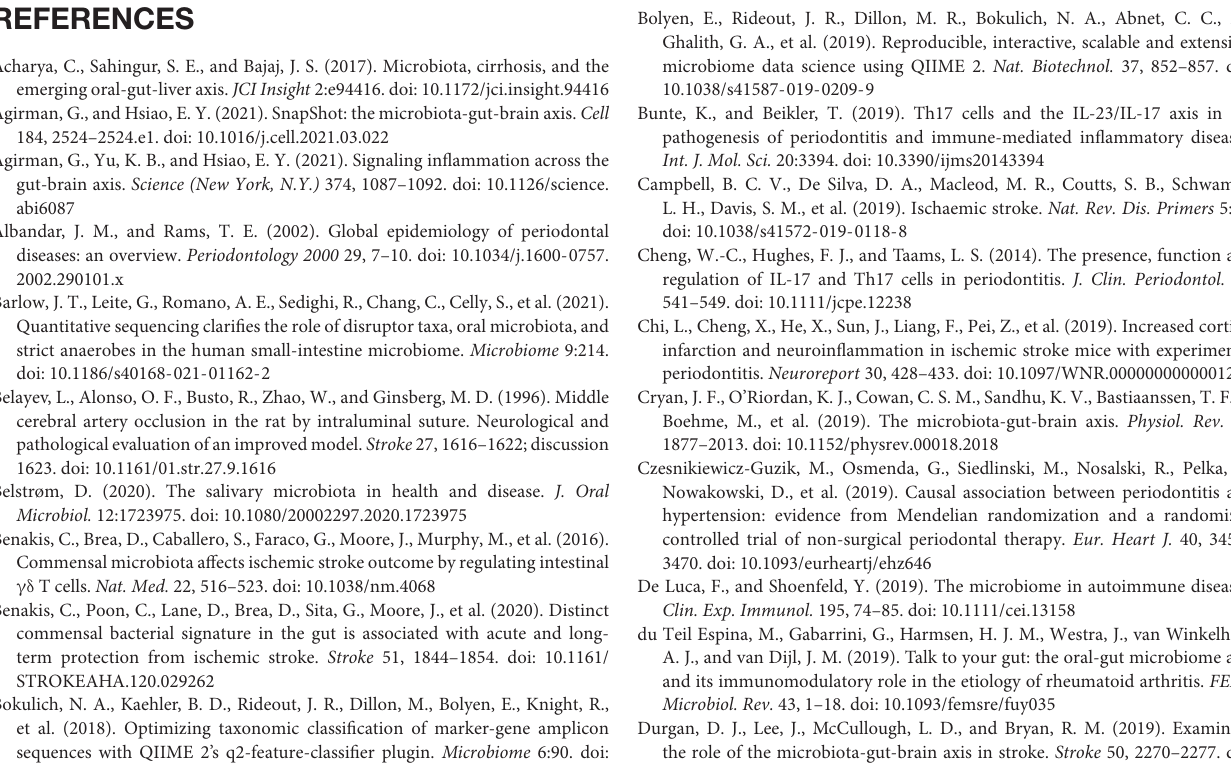
periodontal bacteria in mouse feces by qPCR. Values represent mean ± SD . ns, not significant. ∗ p < 0.05, ∗∗∗∗ p < 0.0001. Supplementary Figure 2 | (A) Gating strategy for flow cytometry analysis of the brain immune cells. (B) Gating strategy for flow cytometry analysis of the intestinal immune cells. Supplementary Figure 3 | Flow cytometry analysis of brain immune cells. (A) Gavage of salivary microbiota of periodontitis patients does not significantly alter the number of CD45 int CD11b + cells in the ischemic brain 1 day after ischemic stroke. Left, representative flow cytometry analysis of CD45 int CD11b + cells. Right, quantification of CD45 int CD11b + cells. n = 6:5:6:6. (B) Gavage of salivary microbiota of periodontitis patients does not significantly alter the number of CD45 int CD11b + CD86 + cells in the ischemic brain 1 day after ischemic stroke. Left, representative flow cytometry analysis of CD45 int CD11b + CD86 + cells. Right, Supplementary Figure 4 | Flow cytometry analysis of CD4 + T cells and TCR- γδ + T cells. The ASPP group had comparable CD4 + T cells and TCR- γδ + T cells with the ASDW and MCAO groups in the small intestine and colon. (A) Quantification of CD45 + CD4 + cells in the small intestine. n = 5:5:6:6. (B) Quantification of CD45 + TCR- γδ + cells in the small intestine. n = 5:5:6:6. (C) Quantification of CD45 + CD4 + cells in the colon. n = 5:5:5:5. (D) Quantification of CD45 + TCR- γδ + cells in the colon. n = 5:5:5:5. Values represent mean ± SD . One-Way ANOVA was used for statistical analysis. ns, not significant.